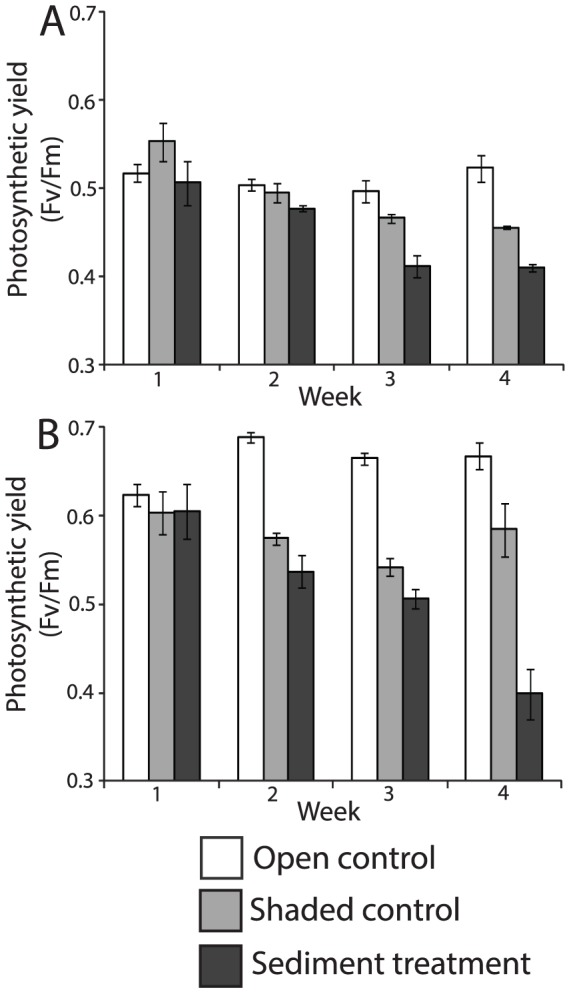
The photosynthetic yield for G.fascicularis (A, C) and G.somaliensis (B, D) over four weeks in the open control (white), shaded control (grey) and sediment treatment (black).The error bars represent standard errors (SE), and n = 4.